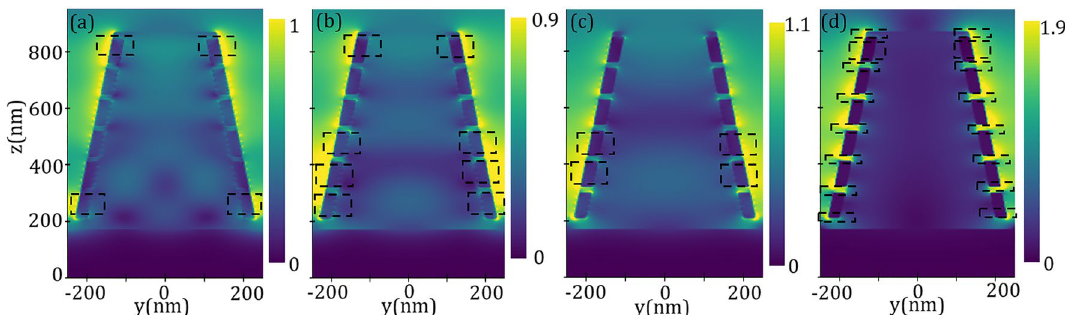
Figure 4. Electric field | E | distributions of the proposed broadband metasurface at yz -plane for resonance wavelengths, ( a ) (cid:31) 1 = 0.69 µ m , ( b ) (cid:31) 2 = 0.96 µ m , ( c ) (cid:31) 3 = 1.36 µ m , and ( d ) (cid:31) 4 = 3.75 µ m . The dashed rectangles localize the enhanced electric fields which are a manifestation for the excitation of the corresponding